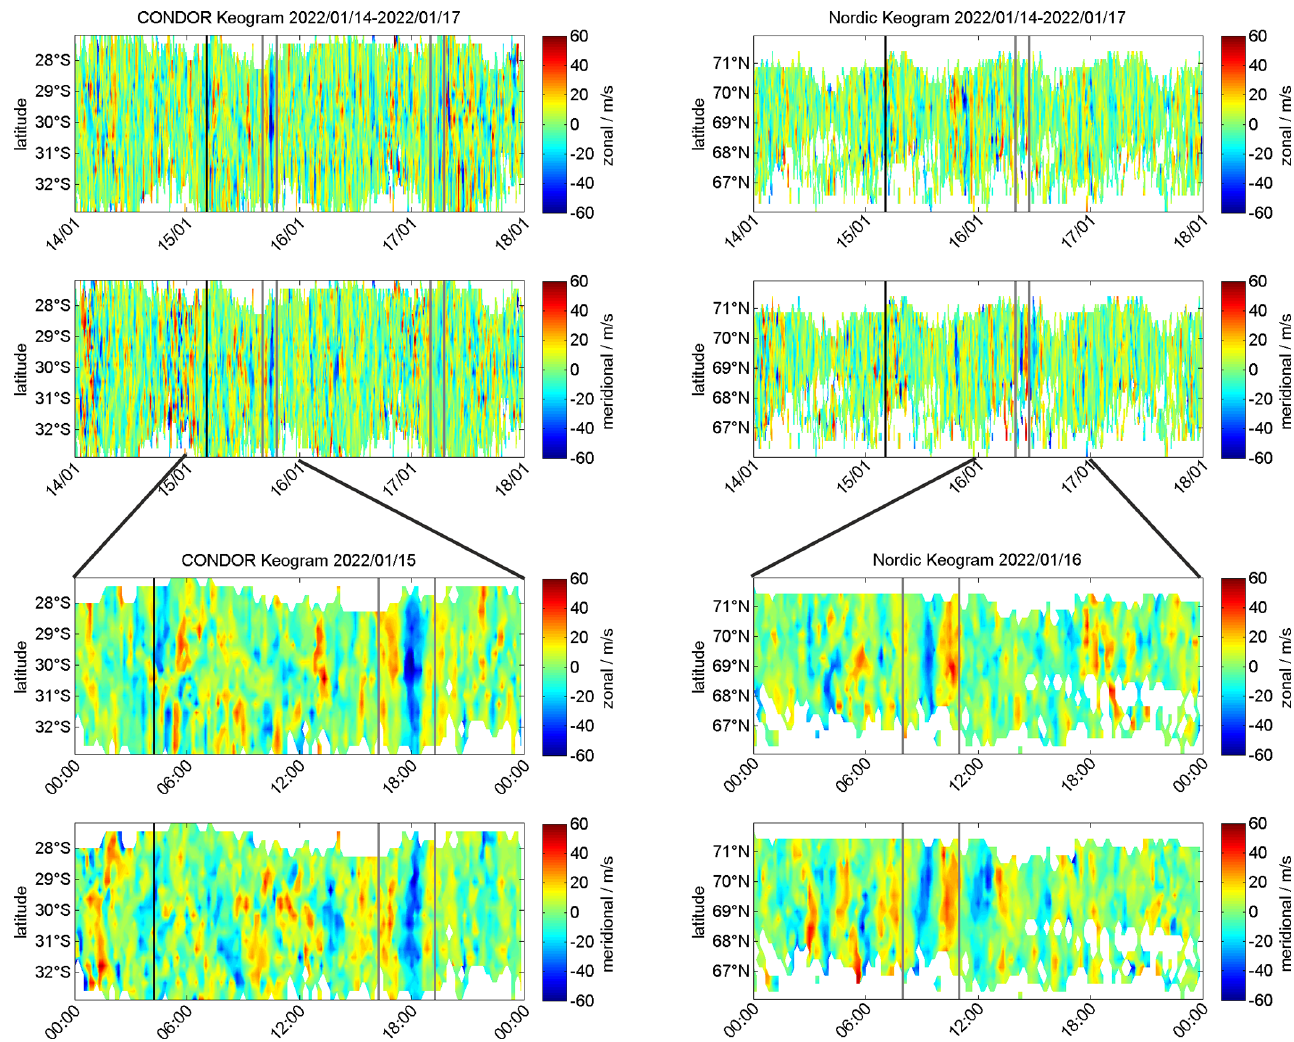
Figure 3. Latitudinal keograms of the vertical average zonal and meridional winds for both domains (upper panels). The lower panels represent shorter-time sections of the first event above CONDOR and the one event at the Nordic Meteor Radar Cluster. Vertical lines are explained in the caption of Fig.